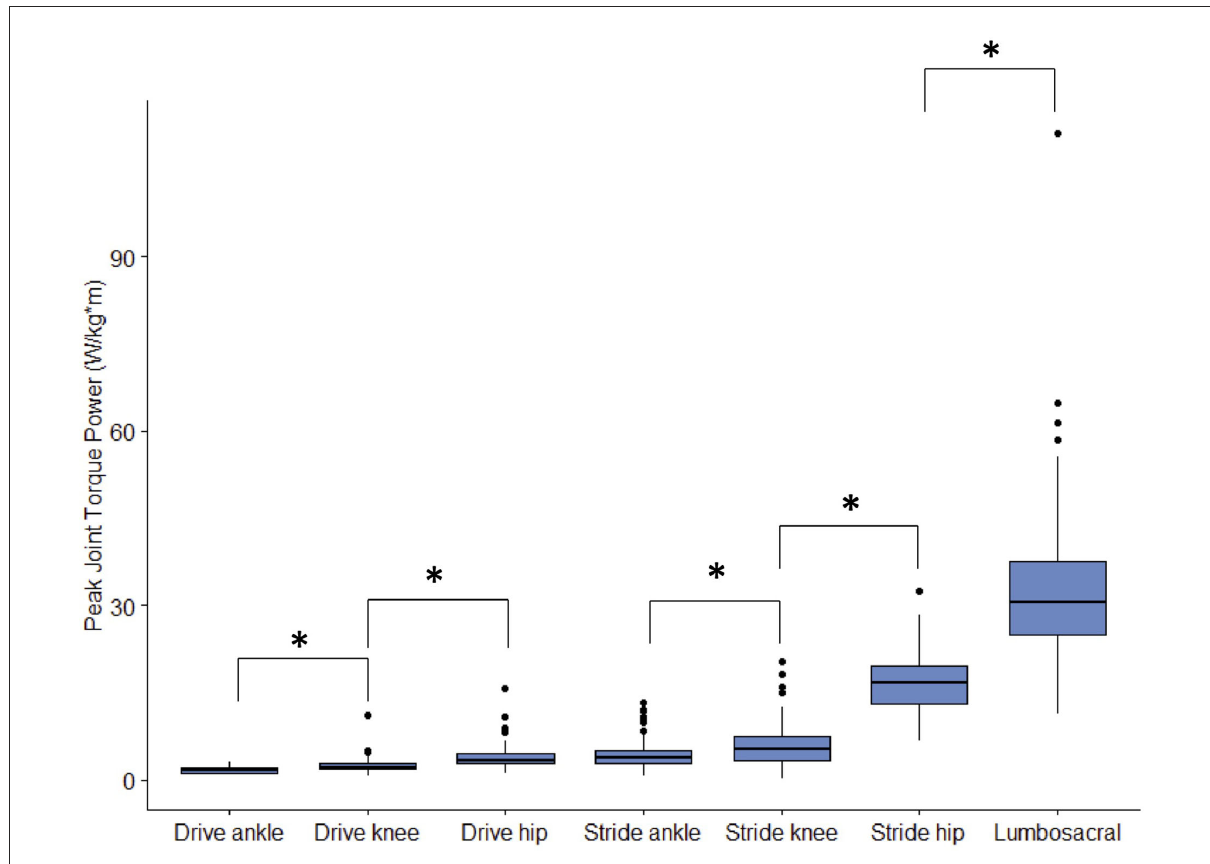
FIGURE6 Peak joint torque power magnitude for each lower body joint from the three fastest pitches thrown for strikes from 23 developmental-aged pitchers. “*” indicates statistically significant differences with p <